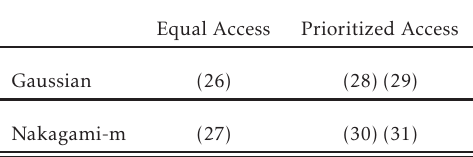
Table 4. Summary of